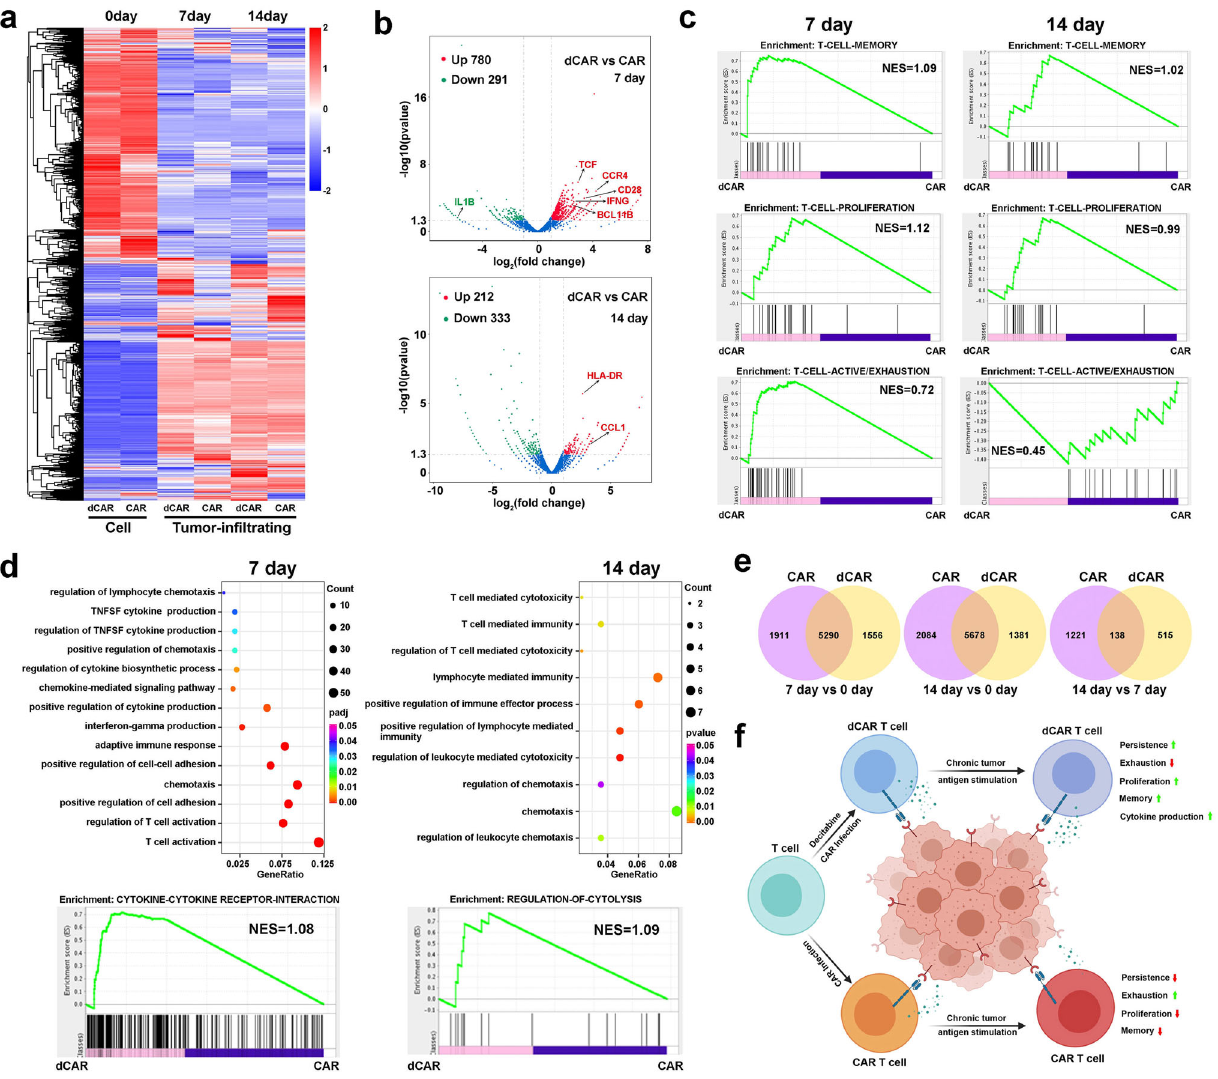
Fig. 10 Tumour-in fi ltrating dCAR T cells show increased effector and memory function compared to tumour-in fi ltrating CAR T cells. a Hierarchical clustering of the RNA-seq analysis results shows signi fi cantly differentially expressed genes between tumour-in fi ltrating dCAR T cells versus tumour- in fi ltrating CAR T cells at different time points after cell infusion. Cluster columns are displaying in groups ( n = 2 replicates per group). b The volcano plot illustrates fold changes in gene expression in tumour-in fi ltrating dCAR T cells compared with tumour-in fi ltrating CAR T cells. Signi fi cantly upregulated genes are shown in red, signi fi cantly downregulated genes are shown in blue, and genes whose difference in expression was statistically nonsigni fi cant are shown in grey. Values are presented as the log2 of the tag counts. c Representative GSEA enrichment plot, demonstrating signi fi cantly upregulation